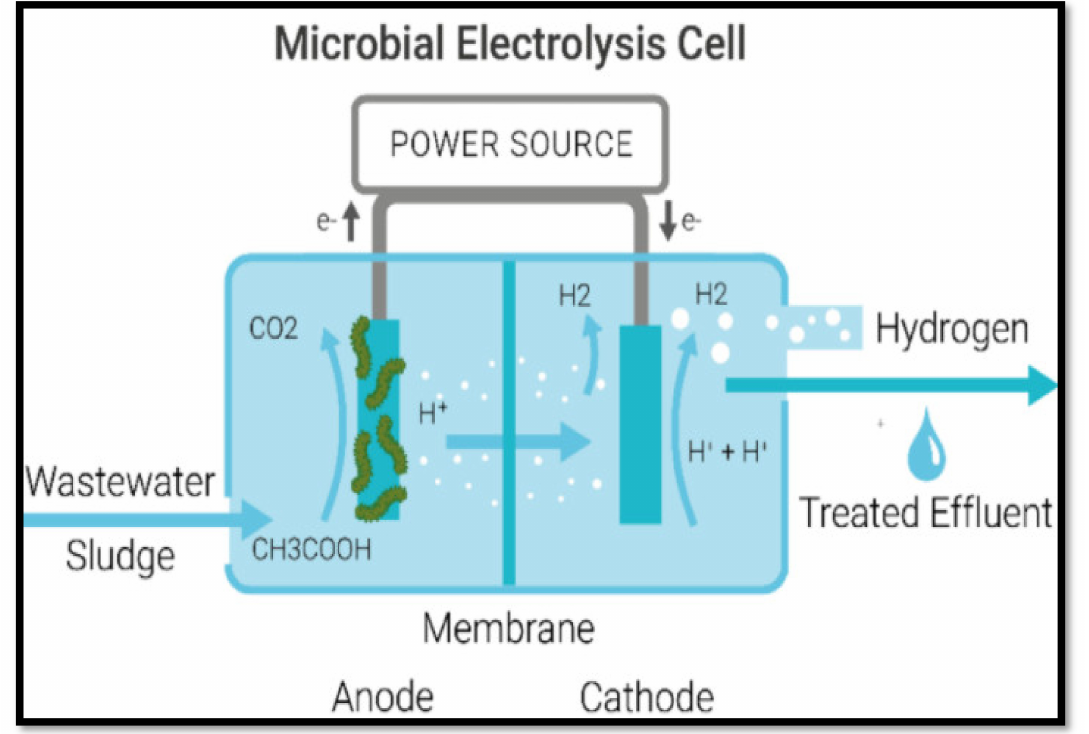
Figure 11. Electrolysis procedures for the treatment of wastewater sludge